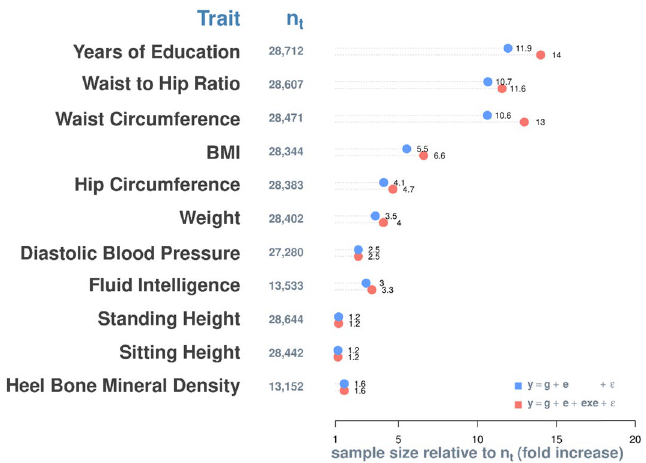
Figure 4. Additional sample size required for the model y = g + ε to achieve the same level of prediction accuracy as y = g + e + ε (blue) and y = g + e + exe + ε (red). n t = sample size of training (or discovery) datasets.